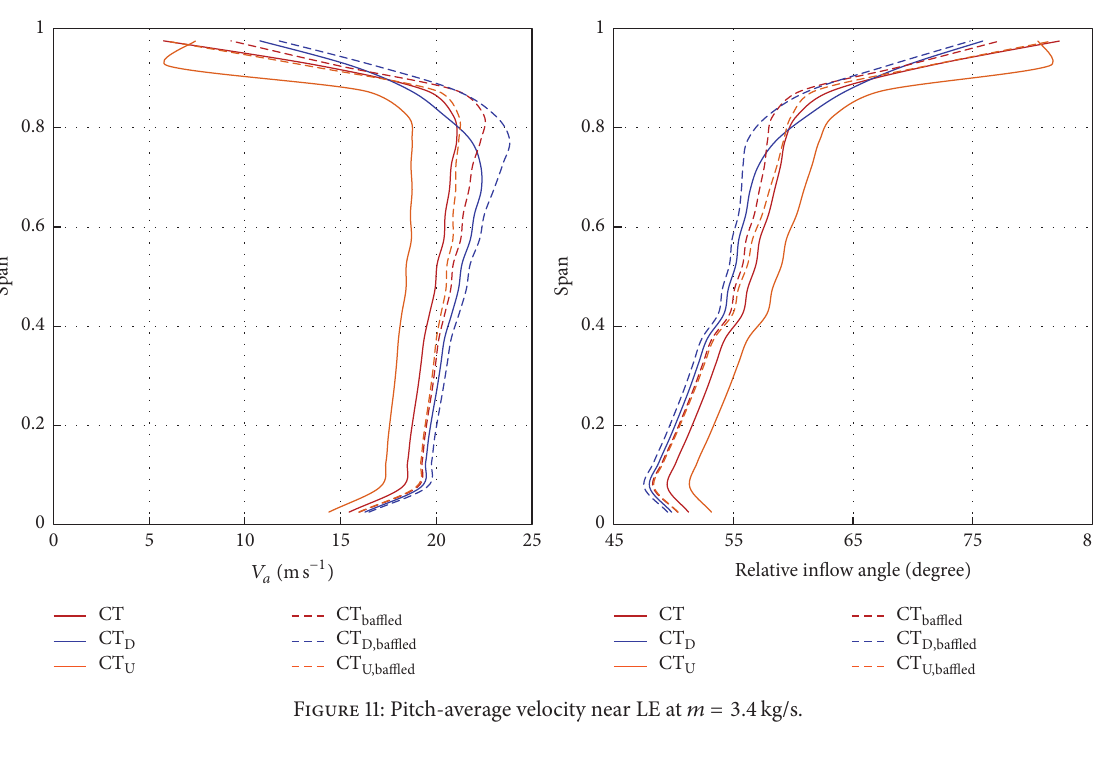
Figure 11: Pitch-average velocity near LE at 𝑚 = 3.4 kg/s.